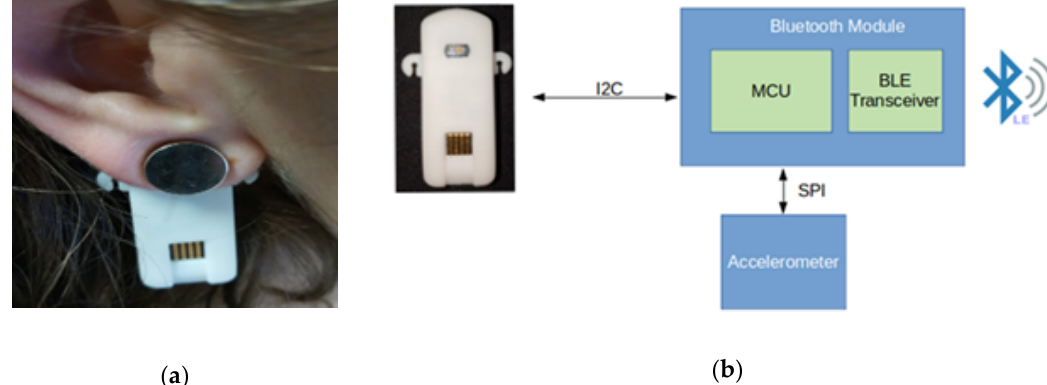
Figure 2. ( a ) James One held in place with a magnet on an earlobe. ( b ) Representation of the main components of the James One PPG sensor.